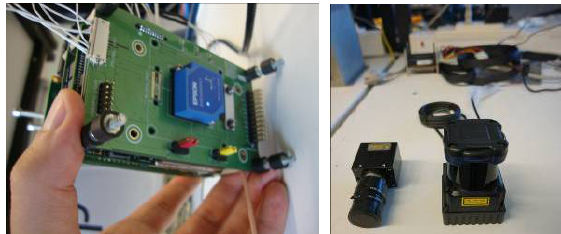
Figure 5. EPSON IMU M-G350-PD11 mounted on CAPTURA (left); Hokuyo LiDAR and Prosilica camera, to be interfaced in VISIONA (right)